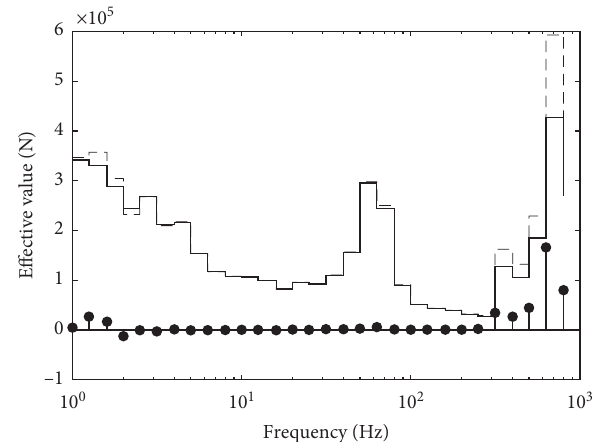
Figure 10: 1/3 Octave band of the wheel-rail contact force ( without settlement; with differential settlement; differences between two